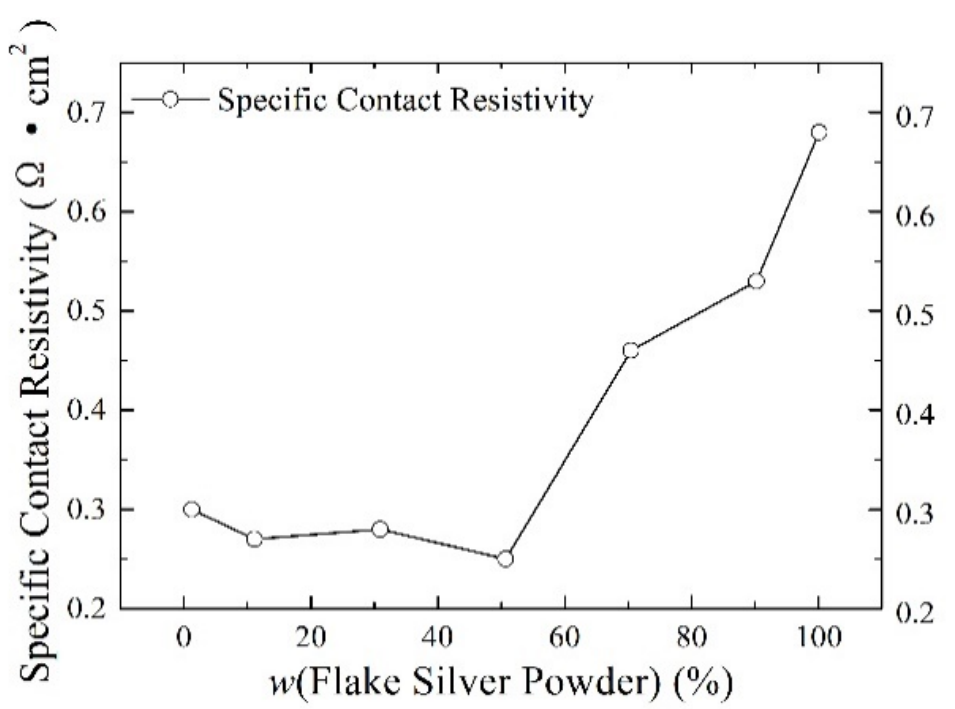
Figure 7. The effect of the flake silver powder content on the adhesion of the sintered silver film.